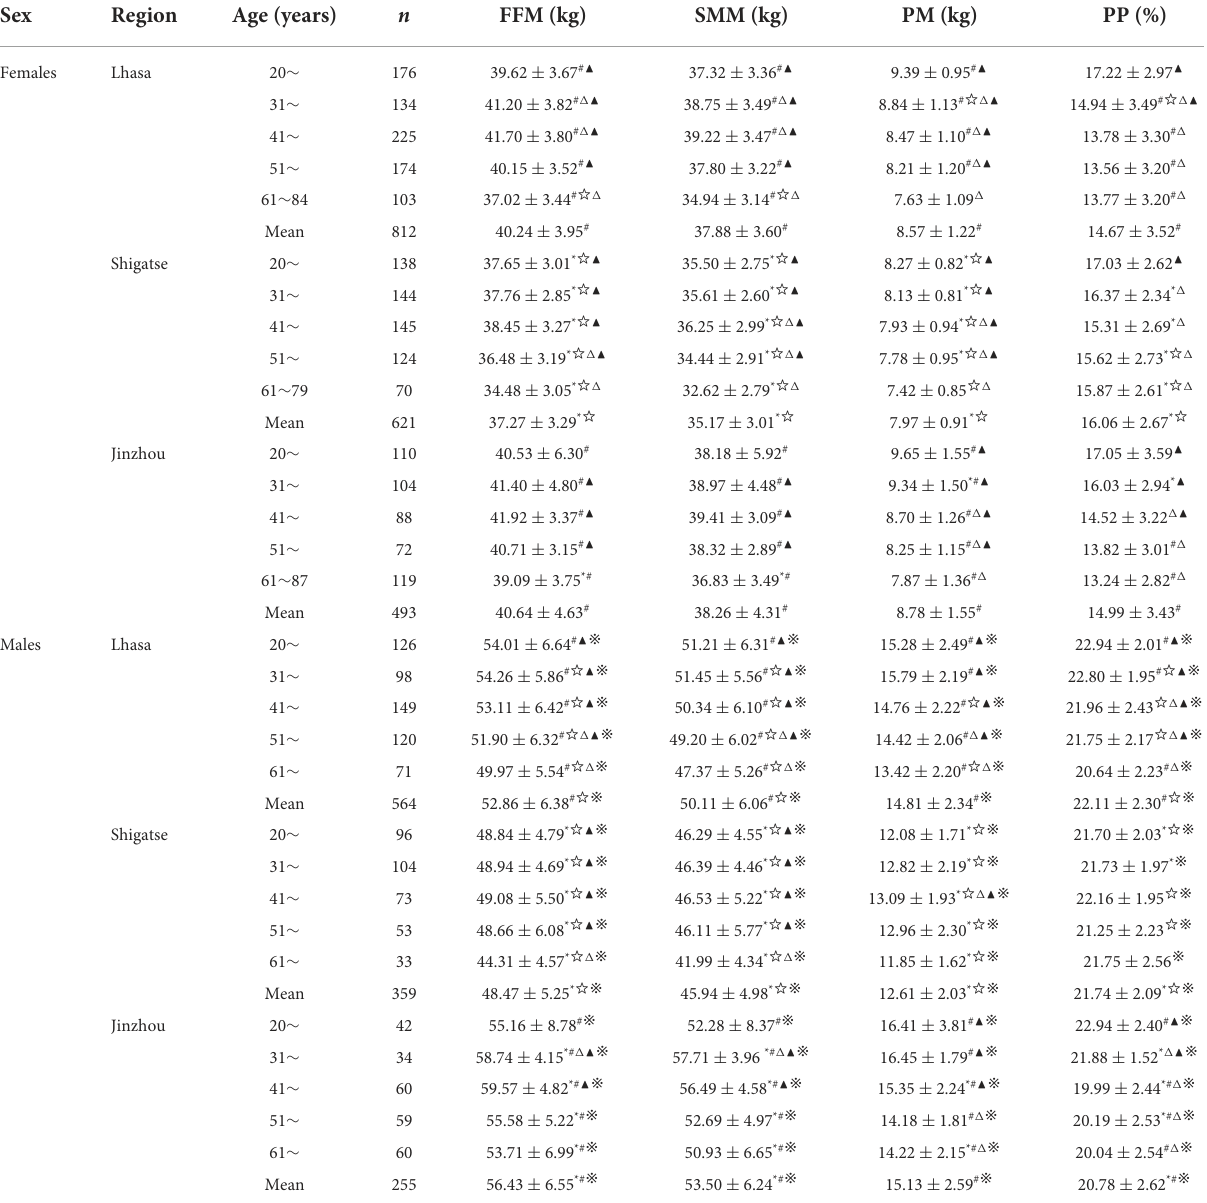
TABLE 2 Sex-specific body composition of protein mass as stratified by age and altitude. Sex Region Females